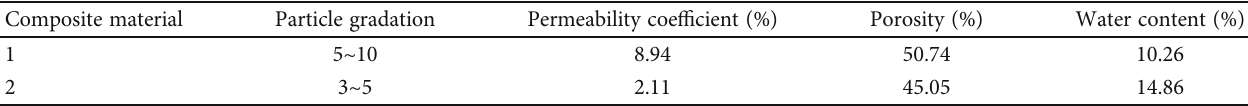
Table 2: Design parameters of porous media.